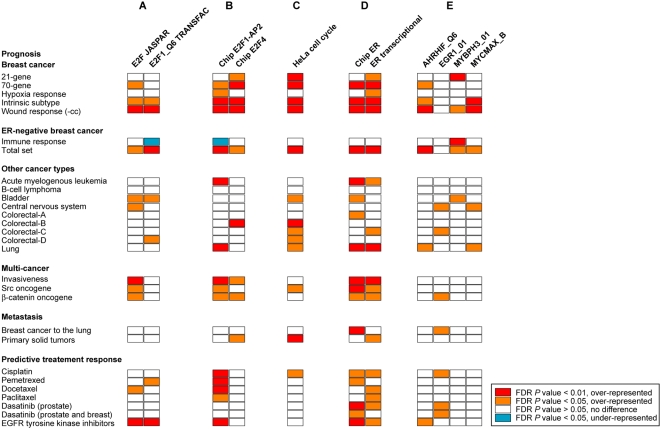
Genomic and transcriptomic properties of cancer signatures associated with the potential for cell proliferation and repressed cell death.
A, representation of E2F motifs based on JASPAR and TRANSFAC matrices and the Poisson distribution, with P values adjusted using the FDR approach for analyses-columns. Values are shown as detailed in the inset: red/orange indicates significant over-representation and blue indicates significant under-representation. The E2F1_Q6 motif represents the putative action of E2F1 and MYC. B, representation of E2F1-AP2 and E2F4 binding sites from chromatin immunoprecipitation (chip) assays using the same statistical methodology as described above. The E2F4 data correspond to the joint analysis of cell cycle phases [23]. C, representation of genes with periodic expression through the cell cycle. D, representation of ER transcriptional regulation from chromatin immunoprecipitation assays or transcriptional changes in MCF7 cells. E, representation of additional promoter motifs using TRANSFAC matrices. The wound response signature without cell cycle-associated genes is indicated by the suffix “(-cc)”, and the “total set” signature of ER-negative breast cancer contains the immune response plus other biological processes such as the cell cycle. The dasatinib predictive signature is divided into two sets for the effect in prostate and breast cancer respectively. The colorectal prognostic signatures are as defined in Table S1.